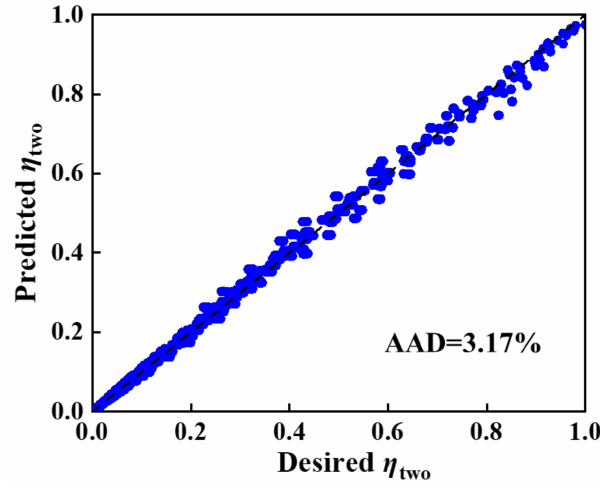
Figure 6. Crossplot between desired and predicted η values for two-layer membranes.